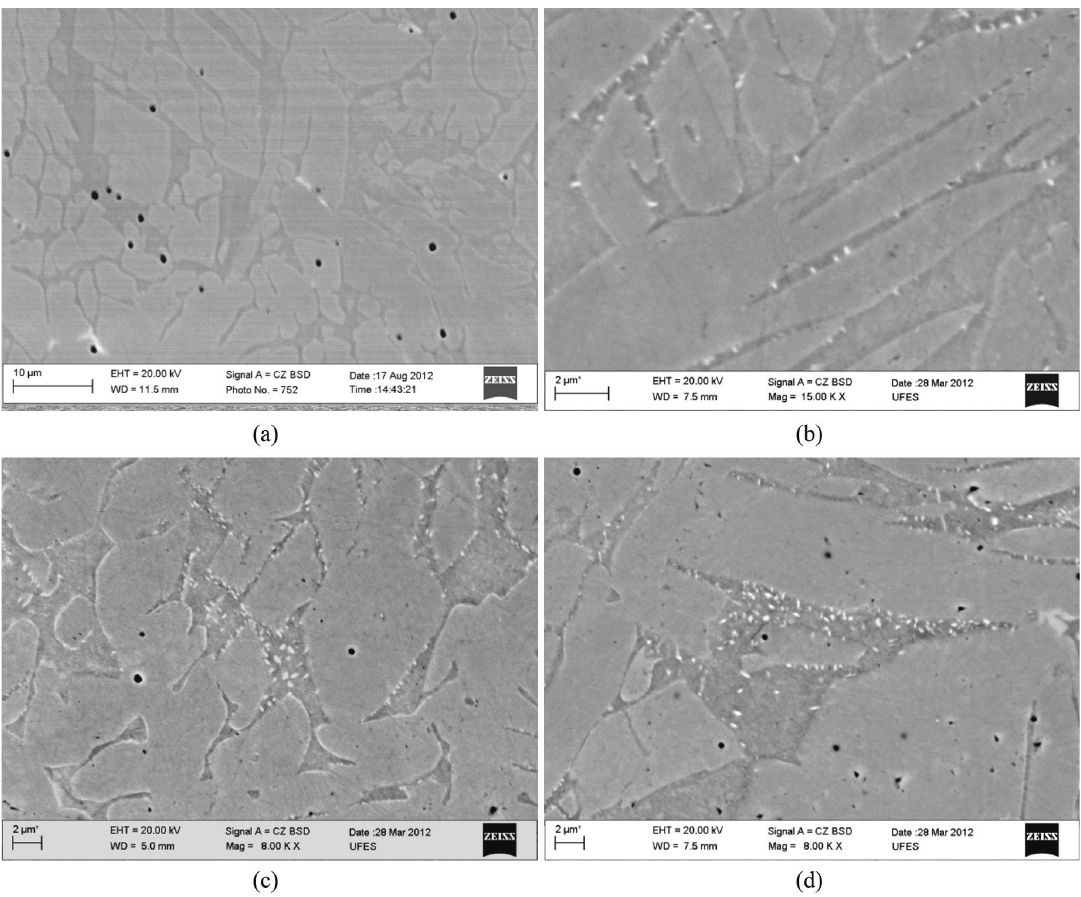
Figure 8. Microstructures of weld metal without etch (BSE mode) after PWHT at 650ºC: (a) 15 min.; (b) 30 min.; (c) 45 min.; (d) 60 min.